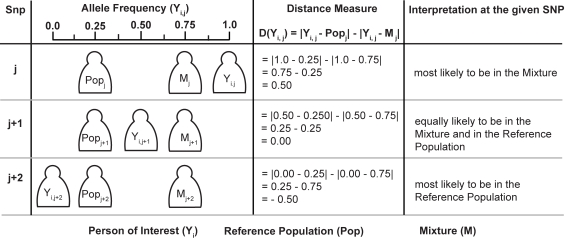
To give insight into the intuition behind our method, we present for a given SNP three different scenarios for the possible allele frequency of the person of interest corresponding to the genotypes AA, AB, and BB.The allele frequencies of the reference population, person of interest, and the mixture are described as Mi, Yi, and Popi respectively. We see that the distance measure is greater (and positive) when the Yi of the person of interest is closer to the Mi of the mixture than to the Popi of the reference population. Similarly, the distance measure is smaller (and negative) when the Yi of the person of interest is closer to the Popi of the reference population than to Mi of the mixture. Our test statistic is then the z-score using this distance measure.